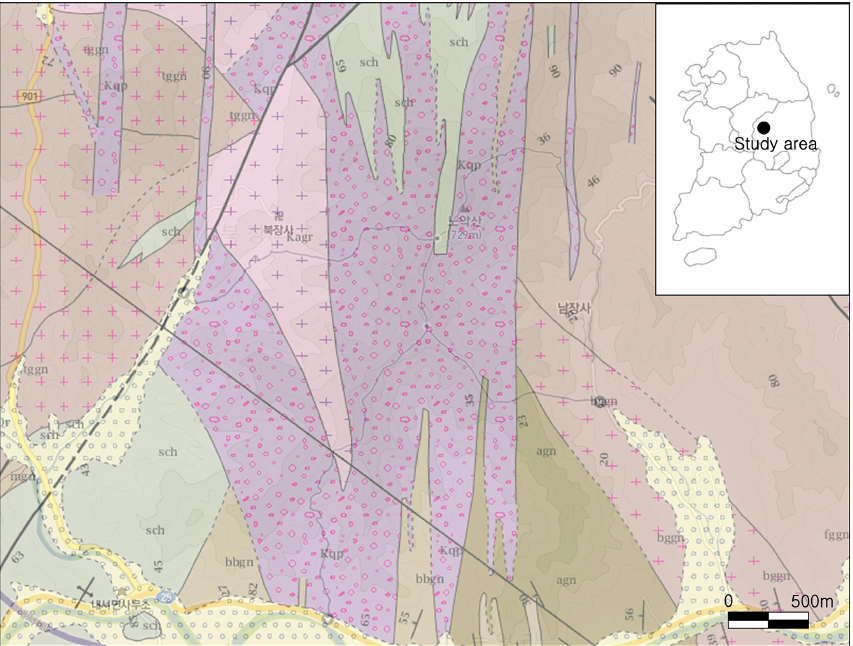
Figure 2. Study area. Kqp: granite porphyry, Kagr: alkali granite, tggn: hornblende granitic gneiss, agn: aplitic gneiss, Qr: river deposits and sch: schist complex.